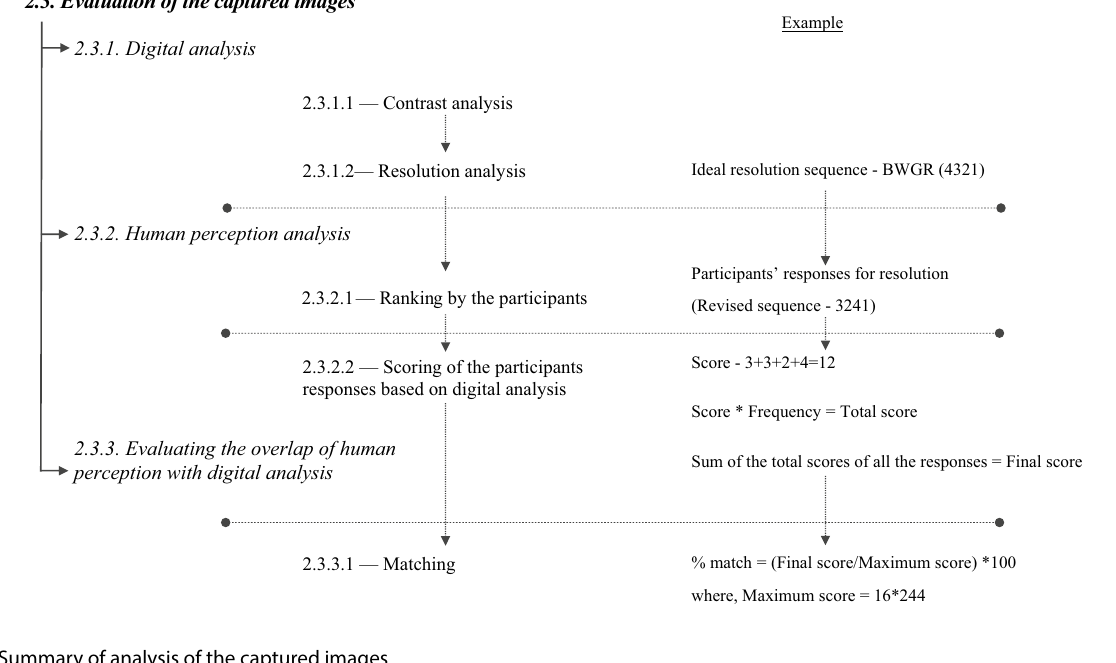
Fig. 1 Summary of analysis of the captured images